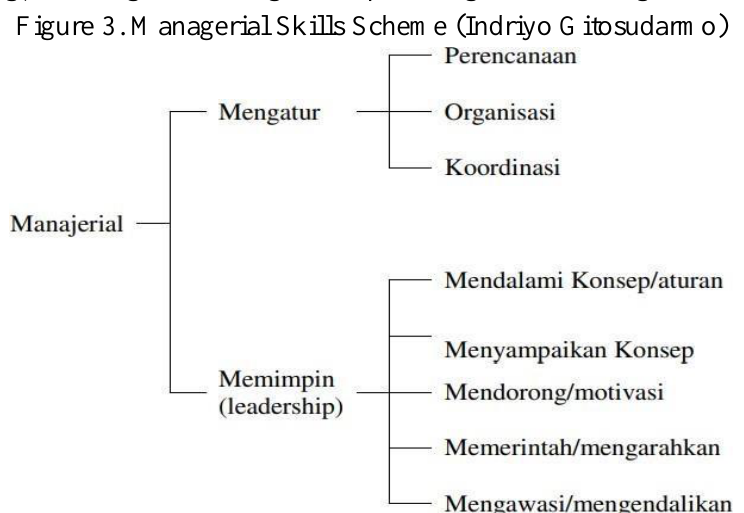
Figure 3. Managerial Skills Scheme (Indriyo Gitosudarmo)